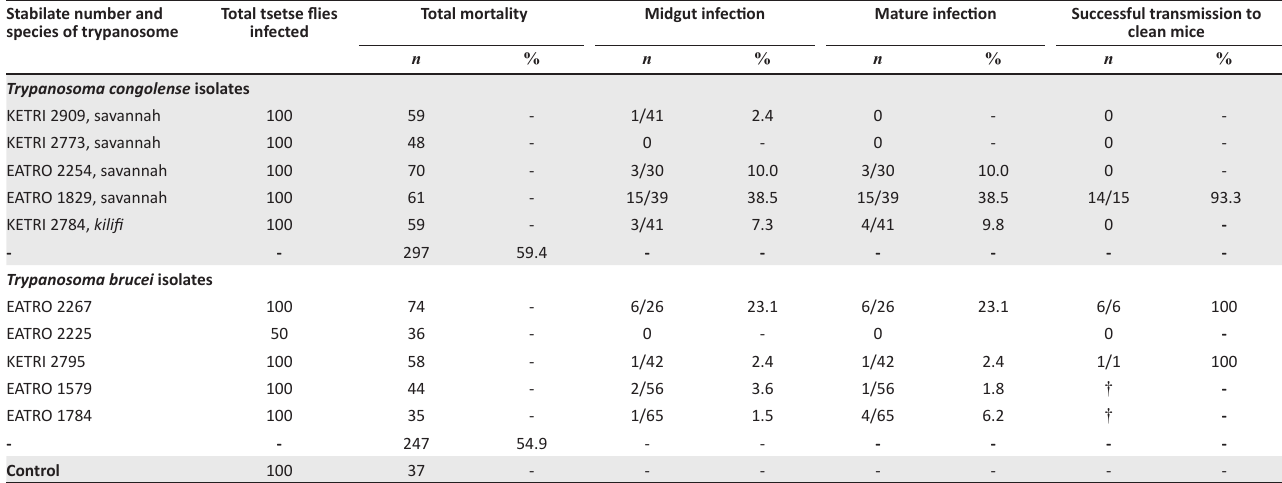
TABLE 3: Tsetse infection, mortality and transmissibility rates. Stabilate number and species of